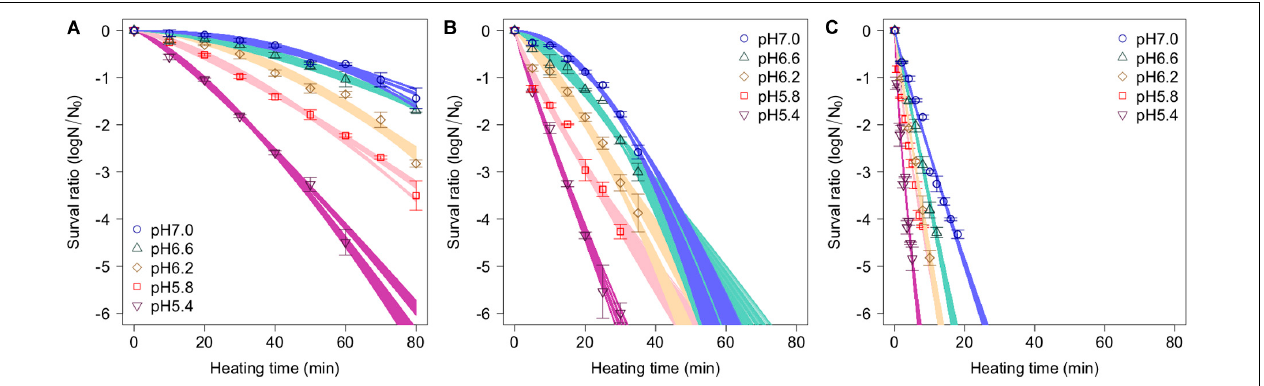
FIGURE 4 | Survival kinetics of Bacillus simplex spores under different temperature conditions, (A) 80 ◦ C, (B) 85 ◦ C, and (C) 90 ◦ C. The points, error bars, and curves indicate, average value of observed survival ratio (three replicates), standard errors of observed survival ratio, and estimated Weibull model curves, respectively, based on 1,000 bootstrap